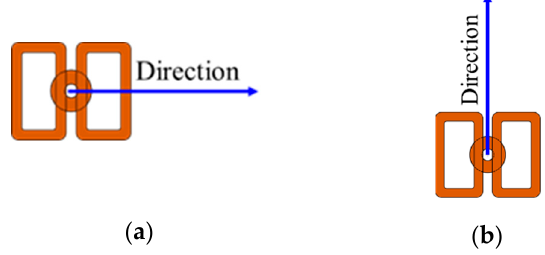
Figure 9. Scanning position of butterfly probe: ( a ) scanning 1; ( b ) scanning 2.